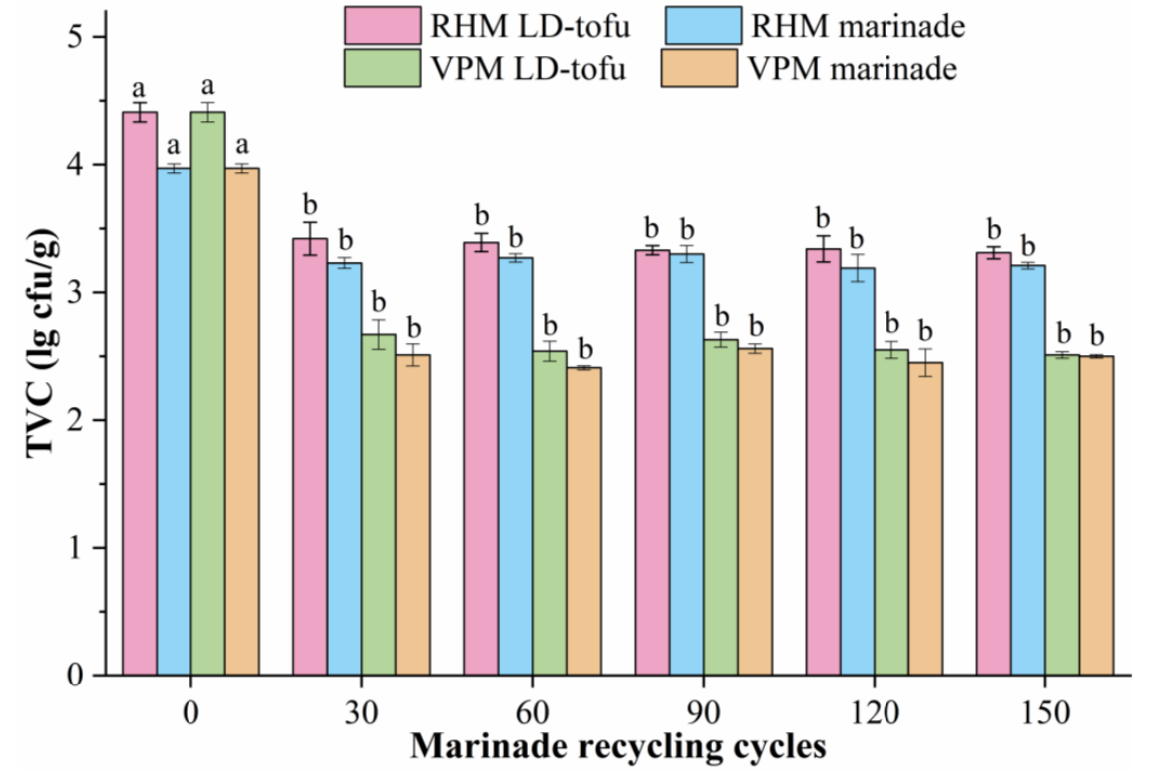
Figure 3. The effects of marinating methods and marinade recycling cycles on the TVC of LD-tofu and marinade. Superscripts with different letters in a row are significantly different between the same sample groups ( p < 0.05).